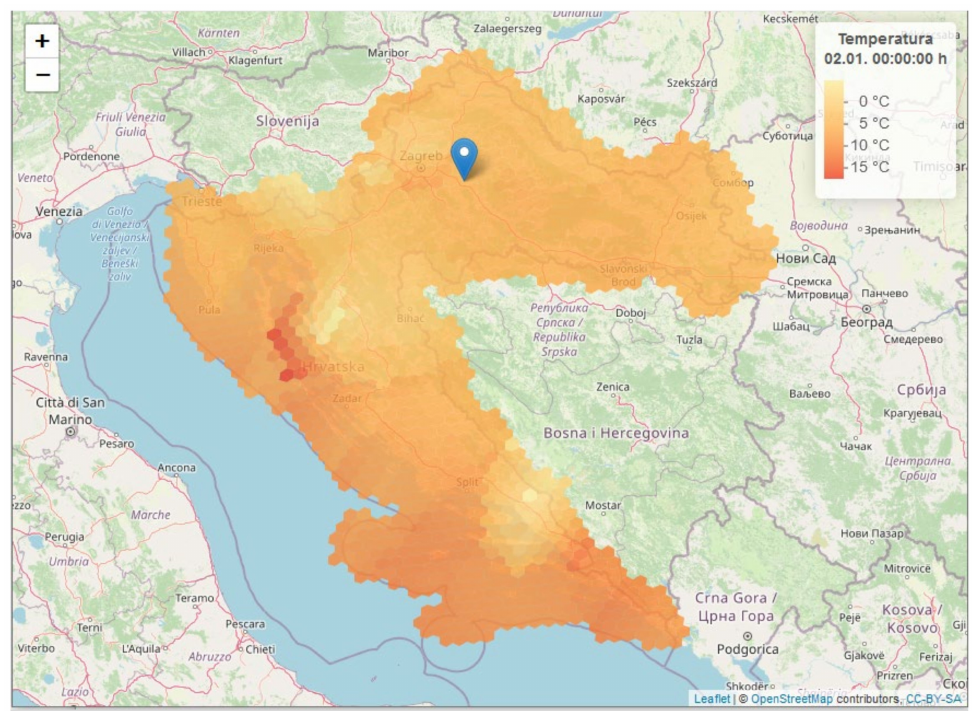
Figure 6. A map used in the questionnaire: YLOrRd color scheme with three colors in ascending order. The user is asked to read the temperature at the marked location (Ivani´c-Grad, Croatia).